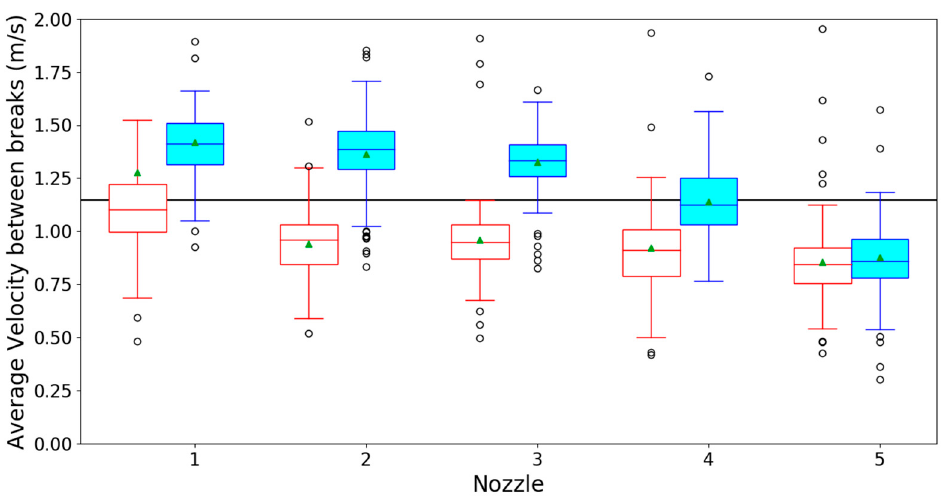
Figure A2. Boxplot graphs of the average liquid velocities in the experiments done with 7 L ⋅ min − 1 for the regular (red boxes) and vortex (blue boxes) showerhead and nozzles 1 (outermost) to 5 (innermost). The green triangles are the calculated population mean. The horizontal black line is the expected liquid velocity calculated using continuity law [15] by taking the flow rate divided by the total nozzle surface area.